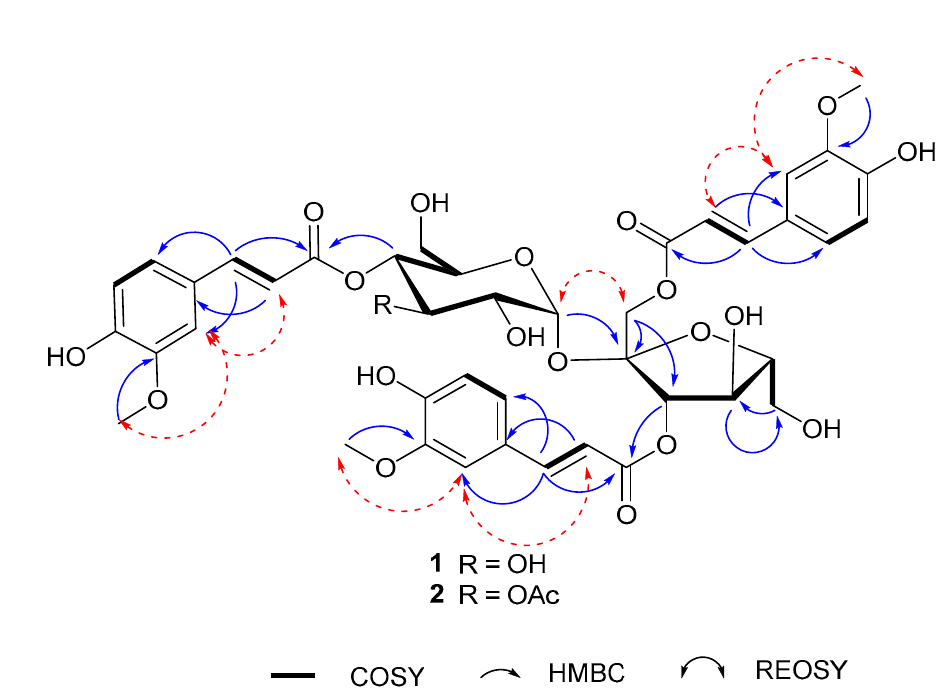
Figure 2. Key 1 H- 1 H COSY, HMBC, and ROESY correlations of 1 and 2 .